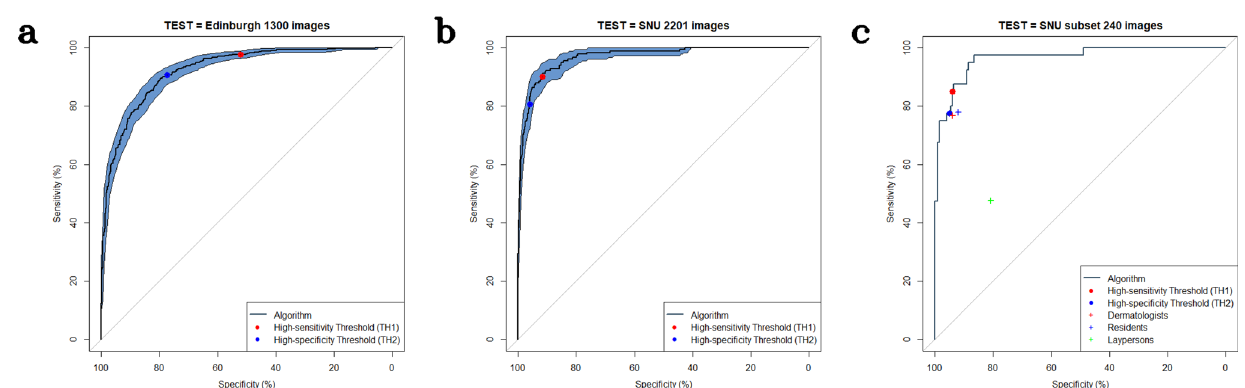
Figure 2. Binary classification for determining malignancy using the hospital (SNU and Edinburgh) datasets. ( a ) TEST = Edinburgh dataset (1,300 images). ( b ) TEST = SNU dataset (2,201 images). ( c ) TEST = SNU public subset dataset (240 images), Red dot (TH1)-The algorithm at the high sensitivity threshold, Blue dot (TH2)- The algorithm at the high-specificity threshold, + − Average of dermatologists, residents, and laypersons in the previous study 17 . The mean sensitivity/specificity using 240 test images was adapted, and the result of the reader study is available at https:// doi. org/ 10. 6084/ m9. figsh are. 64549 73, The shaded area indicates the 95% confidence interval. The TeleDerm dataset was excluded in this malignancy analysis because it includes only four